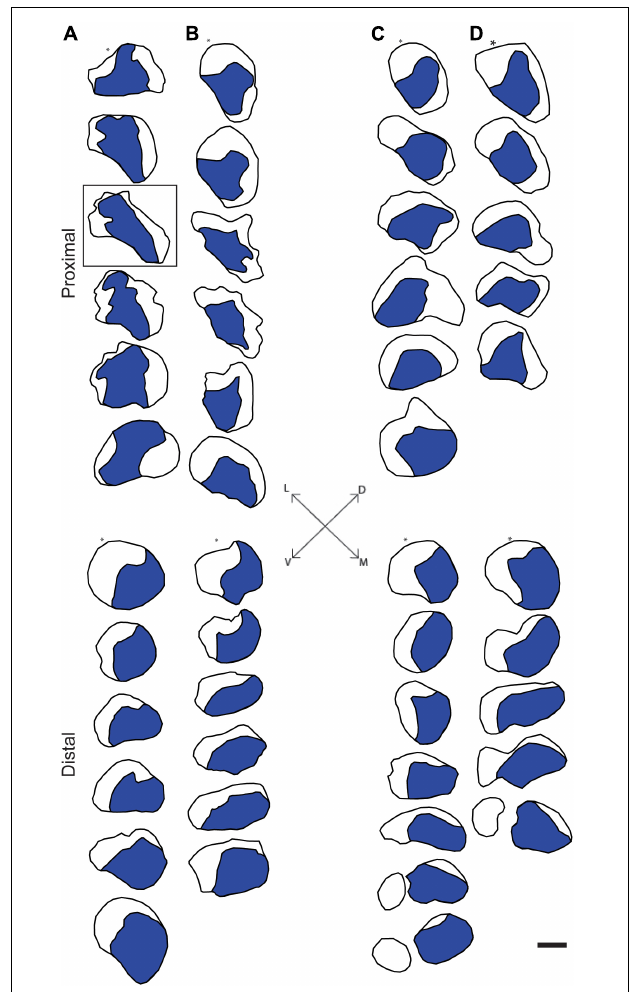
FIGURE 2 | Representative reconstructions of the location of axons contributing to the tibial branch of the left (A,C) and right (B,D) sciatic nerves in a male (A,B) and a female (C,D) rat. Reconstructions were made at 500 µ m intervals but are shown at 1,500 µ m intervals for illustrative purposes. In all cases, Fast Blue-labeled axons (blue areas) were confined to a discrete location along the course of the sciatic nerve proximally from the sciatic notch to the distal trifurcation. Black outlines indicate the transverse area of the entire nerve measured from propidium iodide-stained images. Fiduciary marks indicated by asterisks in each reconstruction. Inset: Dorsoventral and mediolateral directions. Box indicates reconstruction of the same section shown in Figures 1A,B . Scale bar = 500 µ m.